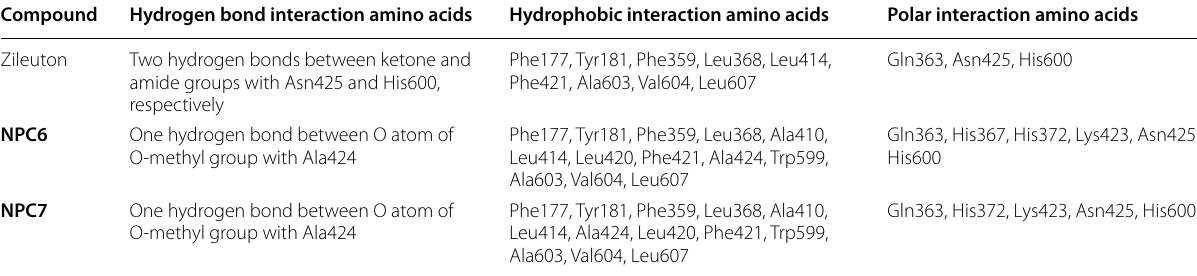
Table 5 Binding interaction analysis of the active compounds in 5-LOX active site Compound Hydrogen bond interaction amino acids Hydrophobic interaction amino acids Polar interaction amino acids Zileuton Two hydrogen bonds between ketone and amide groups with Asn425 and